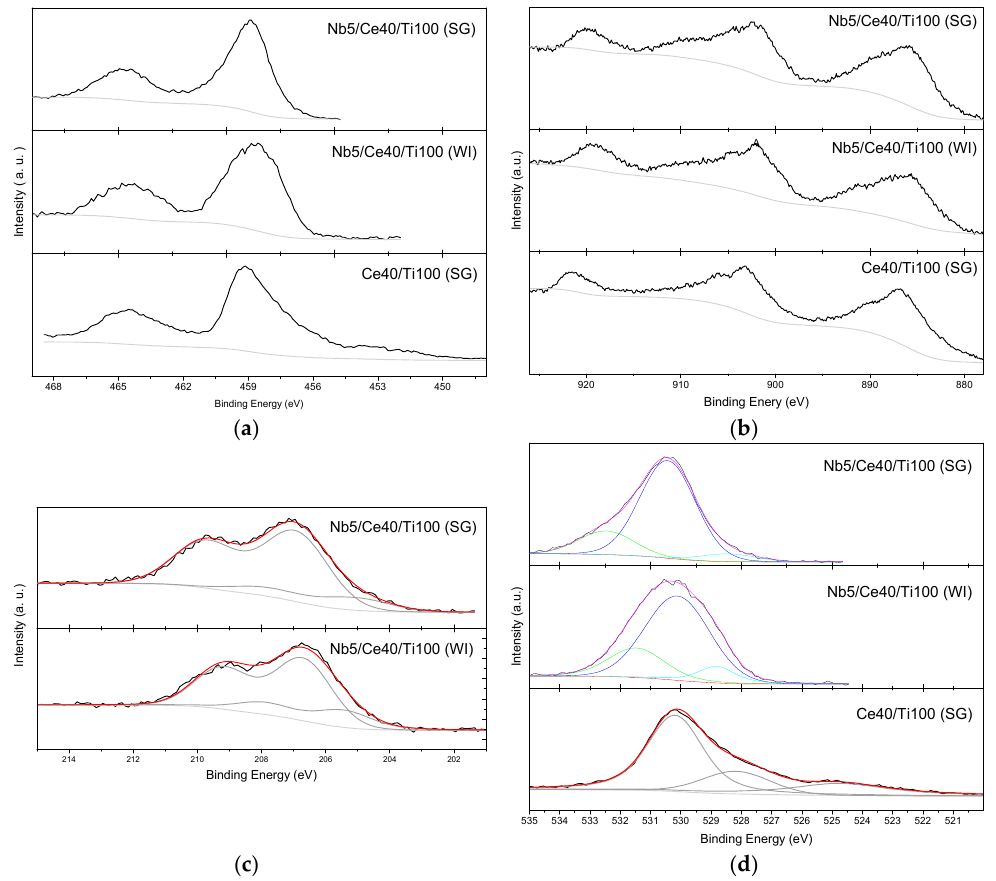
Figure 8. XPS data of the Ceria-containing catalysts: ( a ) Ti 2p, ( b ) Ce 3d, ( c ) Nb 3d, and ( d ) O 1s.